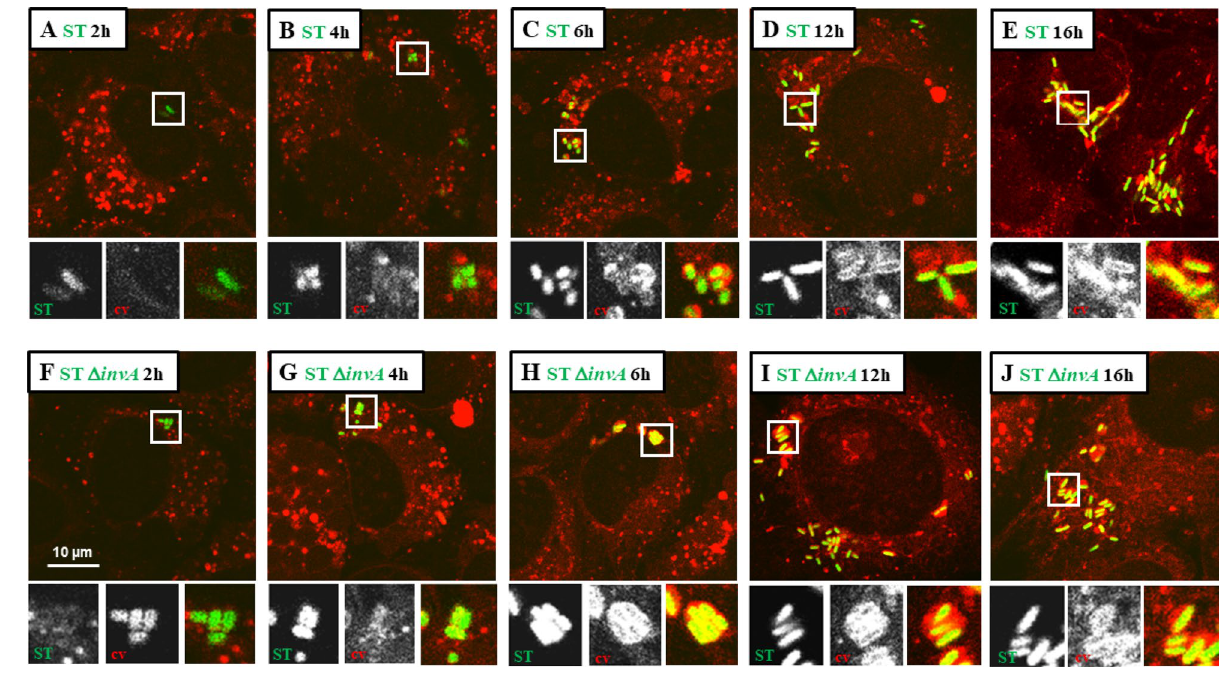
Figure 10. Salmonella Typhimurium progressed in acidified organelles in AML12 cells. The kinetics of vacuole acidification was processed for AML12 cells infected with ST GFP and ST Δ invA GFP at ( A , F ) 2 h, ( B , G ) 4 h, ( C , H ) 6 h, ( D , I ) 12 h and ( E , J ) 16 h pi. At each time point after 5 min exposure to 1 µM cresyl violet (cv) (red), cells were directly imaged using confocal microscopy with a 100 × oil immersion objective (Leica TCS SP8, Germany). Squares outlined in white are a 2 × manual magnification of select regions so as to visualize progressive organelle acidification. Scale bars 10 µm.